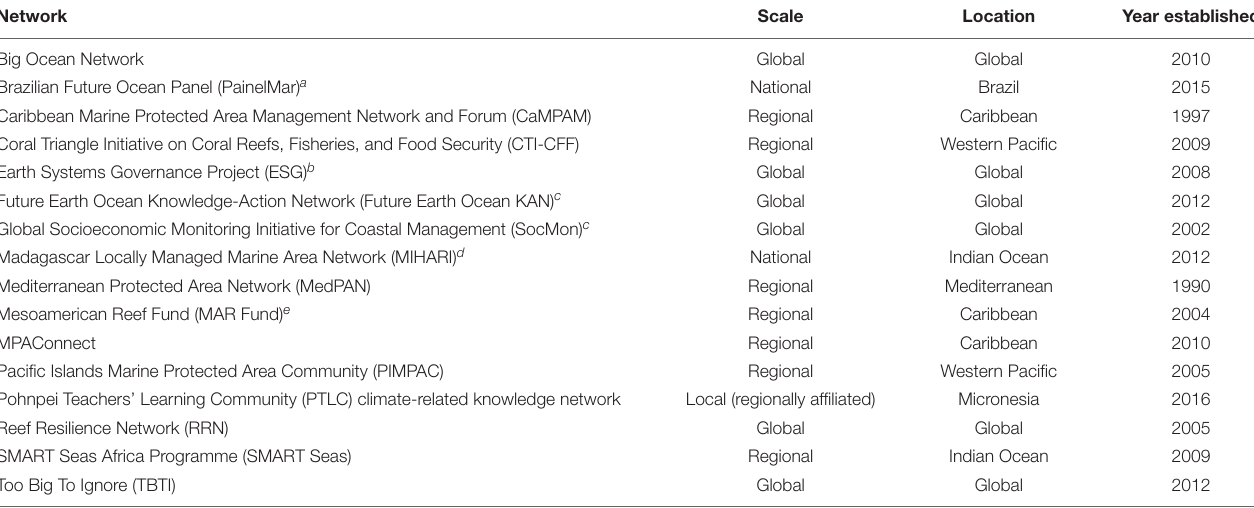
TABLE 1 | The 16 networks included in our study, as well as the scales and locations in which they operate and the year each network was established.